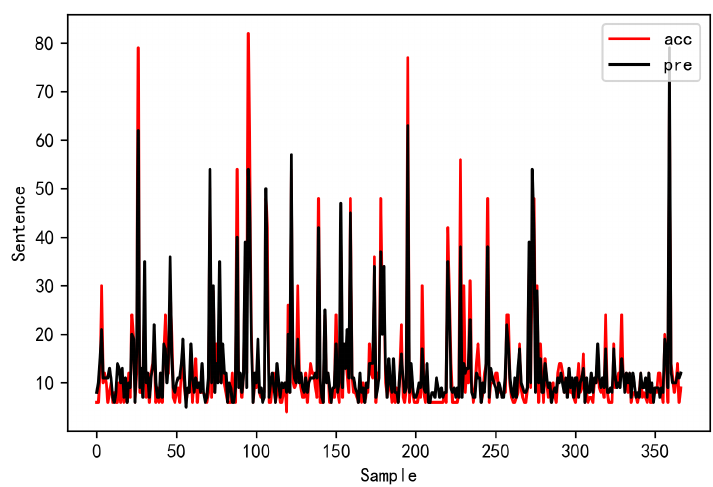
Figure 5. Line graph of actual and predicted